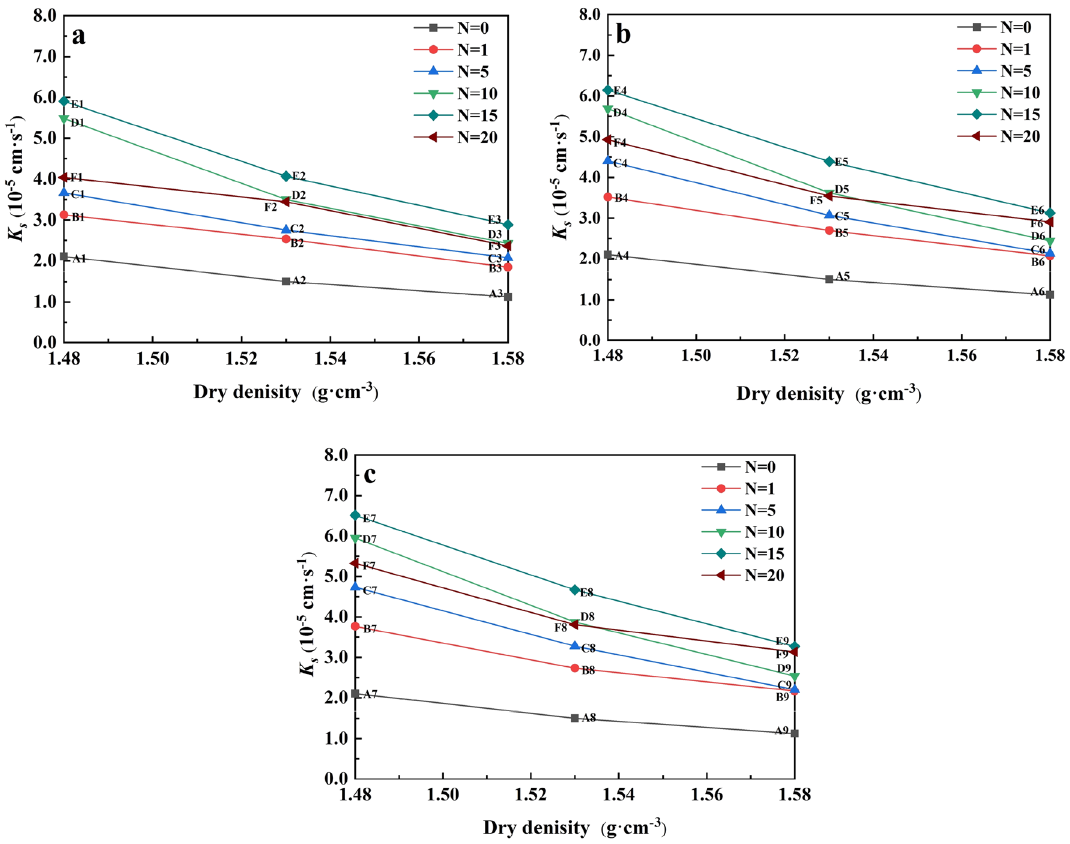
Figure 9. The changes of K s with dry density of water-remolded saline–alkali soils at the study site in the floodplain of southwestern Shandong Province: ( a ) ω = 13%, ( b ) ω = 16% and ( c ) ω = 19%.